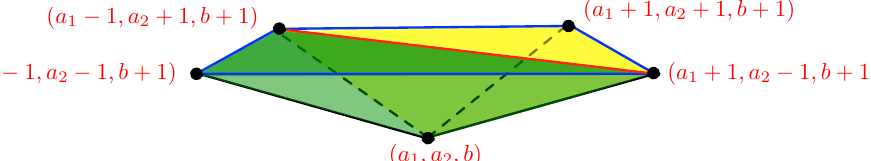
Figure 9. The pyramid is split into two tetrahedra (along the red line in the ground plane of the pyramid).